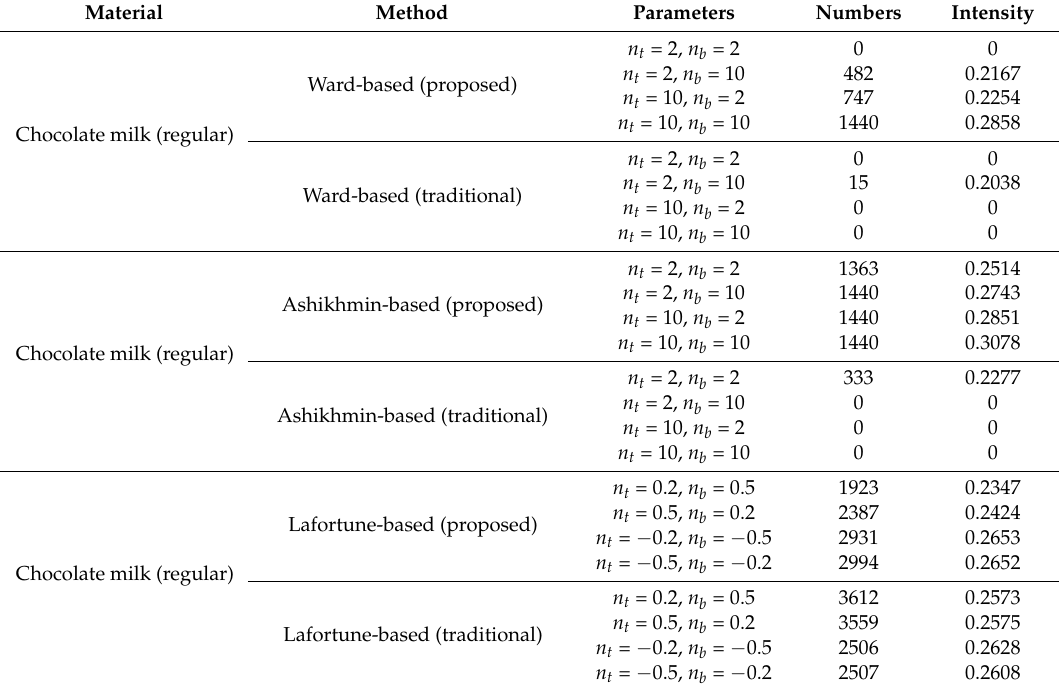
Table 2. Number and Intensity of generated highlight for chocolate milk (regular)